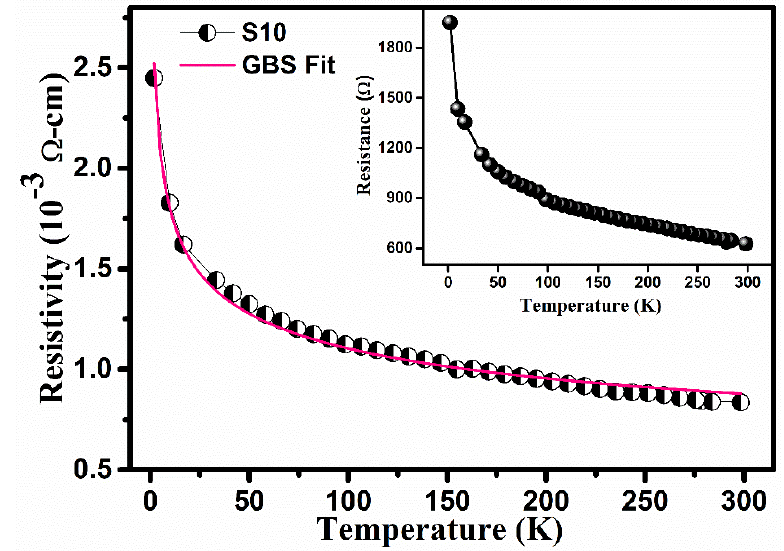
Figure 7. Resistivity vs. temperature for the sample S10 fitted with a GBS conductivity relation; the inset is the RT plot.